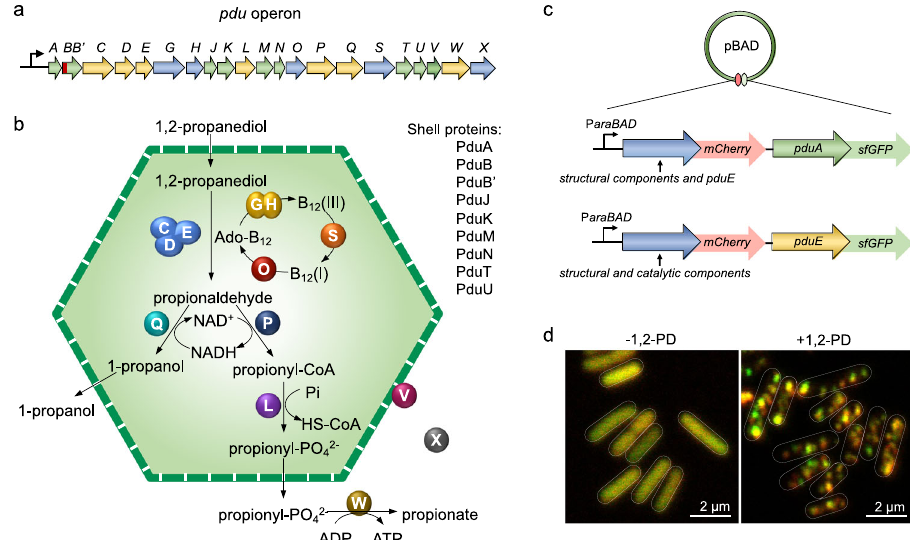
Fig. 1 A system to investigate Pdu BMC biogenesis. a The chromosomal pdu operon of S . Typhimurium LT2 encodes structural genes ( pduABB ’ JKMNTU ), catalytic genes ( pduCDELPQW for 1,2-propanediol degradation, and the pduGHOSX B 12 recycling genes), and pduV (proposed to connect with fi lament- associated BMC movement 39 ). PduM is listed as a structural protein according to the previous studies 28 . b The Pdu BMC shell encapsulates key enzymes that are required for 1,2-propanediol metabolism. c All Pdu proteins are visible by dual-labeling with fl uorescence proteins (mCherry and sfGFP). Two series of vectors were constructed. First, PduA (a major shell protein) was labeled with sfGFP, and other structural components or PduE (a major enzymatic component) were labeled with mCherry. Second, PduE was labeled with sfGFP, and the structural components or other catalytic components were labeled with mCherry. d The presence of 1,2-propanediol (1,2-PD) is required to visualize Pdu BMCs. The fl uorescence images show WT S . Typhimurium LT2 carrying pBAD-PduE-mCherry/PduA-sfGFP grown in microcompartment-inducing media (MIM), in the absence ( − 1,2-PD) or presence ( + 1,2-PD) of 1,2-